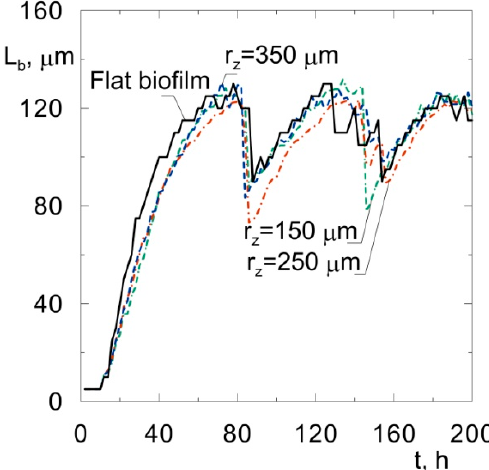
Figure 2. Biofilm thickness vs. time of biofilm growth on spherical particles of different radiiand on a flat substratum.